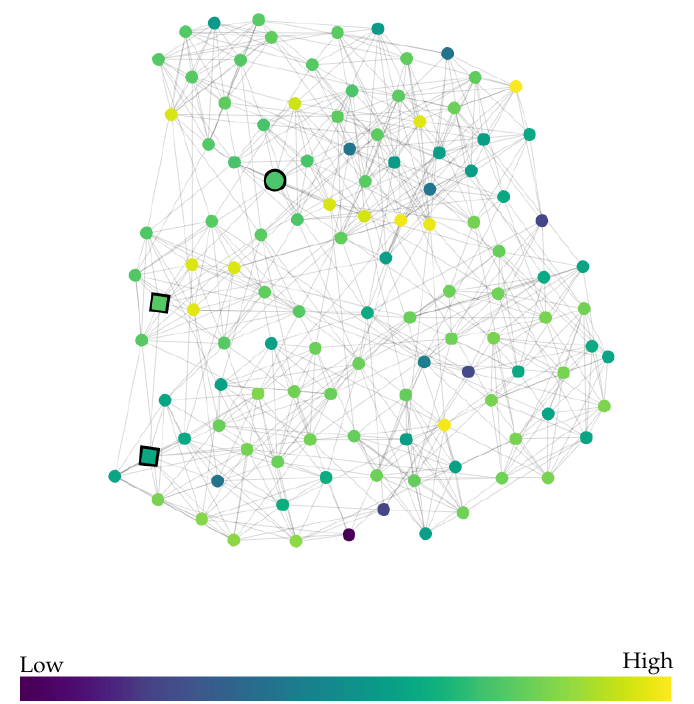
diagram along with a colormap legend. Dataset: football ; colormap: viridis ; node attribute: PageRank . Link to the user study: